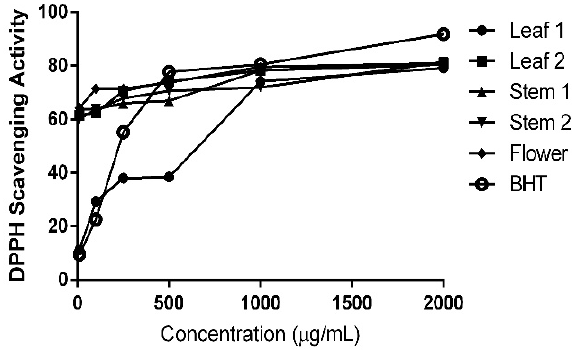
Figure 1: DPPH radical scavenging activity of M. sativa L. extracts at different growing period and standard compound BHT.